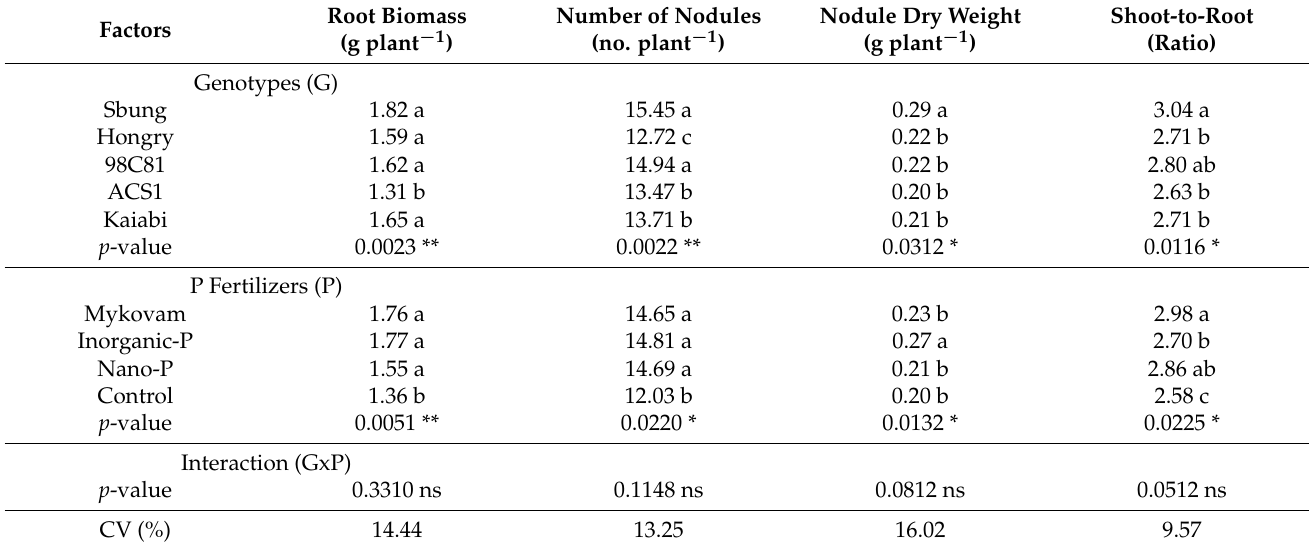
Table 9. Root biomass, number of nodules, nodule dry weight, and shoot-to-root ratio, as affected by genotypes and P fertilizer